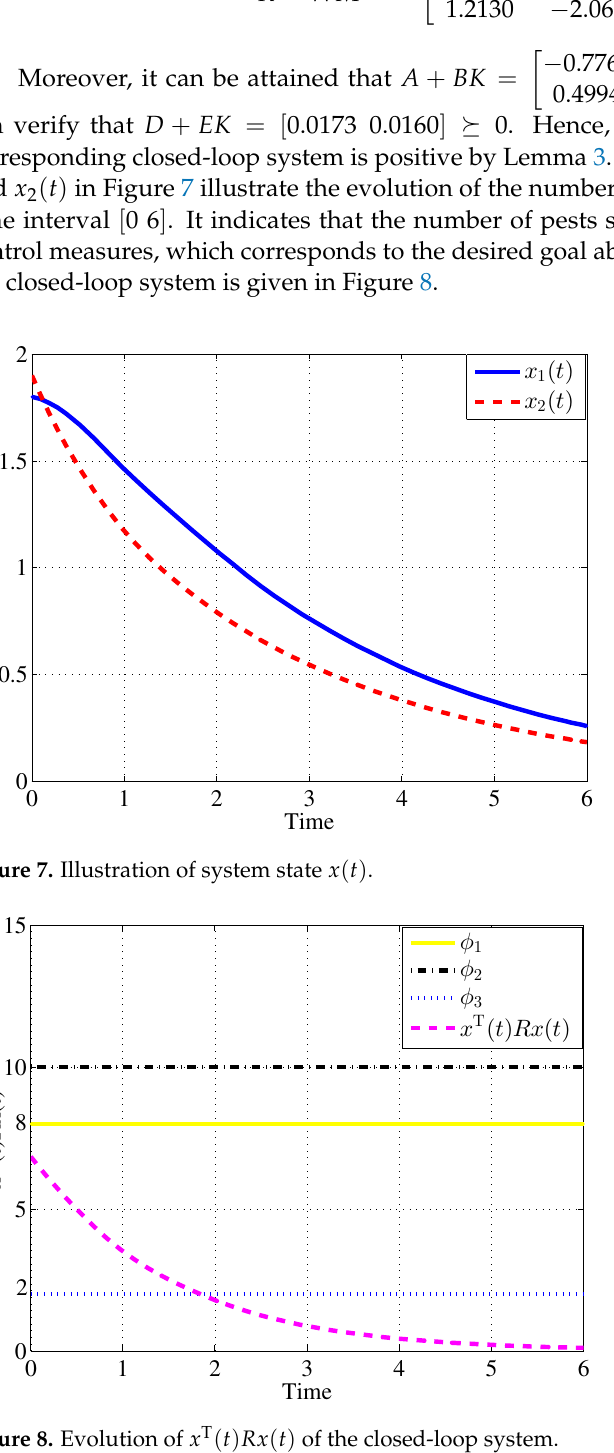
Figure 8. Evolution of x T ( t ) Rx ( t ) of the closed-loop